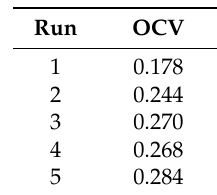
Table 12. OCV of the stack before each MPPT run.